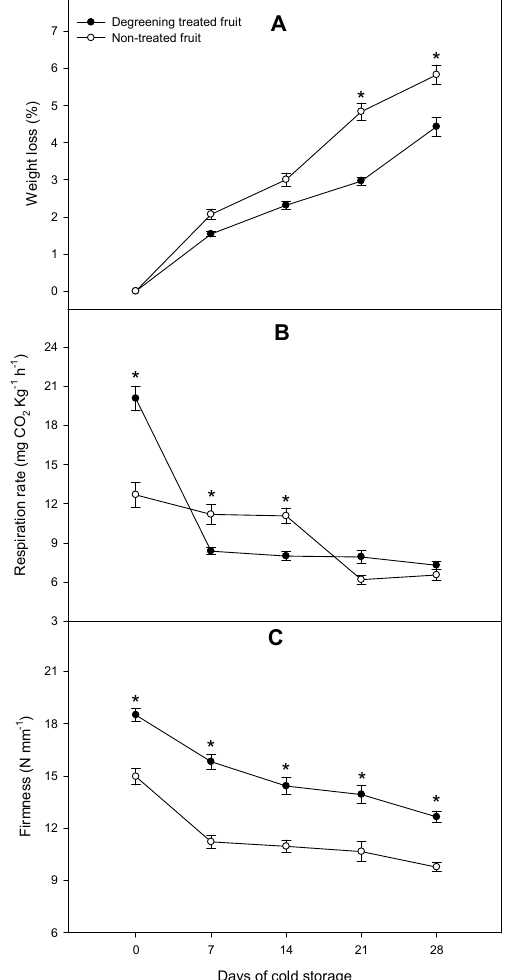
Figure 2. Effect of degreening treatment on weight loss ( A ), respiration rate ( B ), and firmness ( C ) in lemon fruits stored during 28 days at 10 °C. Asterisks (*) show significant differences between treated and non-treated fruits at p < 0.05.